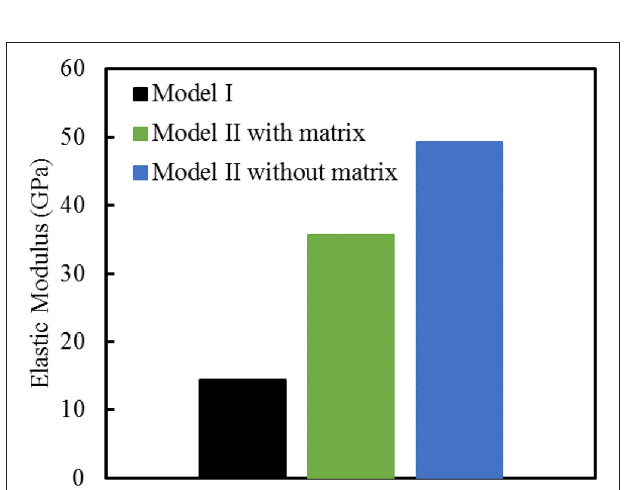
FIGURE 11 | Longitudinal tensile elastic moduli for different geometric models of bone. The strength of the interface is 64 MPa, and the fracture energy is 0.2 J/m 2 .